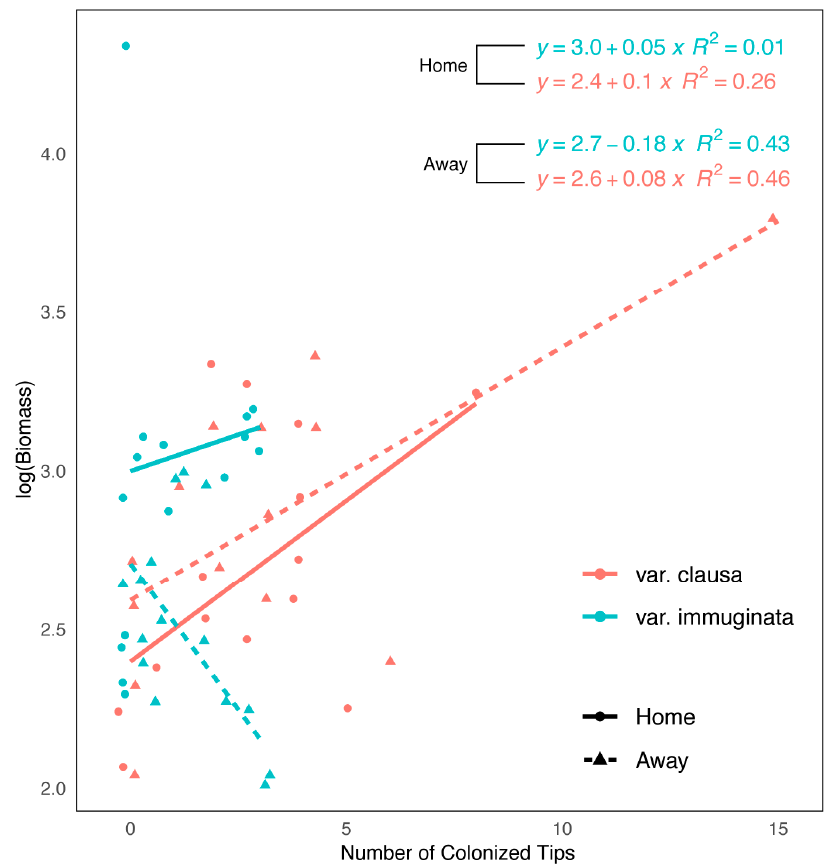
Figure 6. Total plant biomass as a function of number of colonized tips for the Pinus clausa seedlings from the var. clausa (salmon) and var. immuginata (teal) varieties grown in their own soil (“Home”; solid line with circle points) or soil from the other variety (“Away”; dashed line with triangular points). Regression statistics are also included.